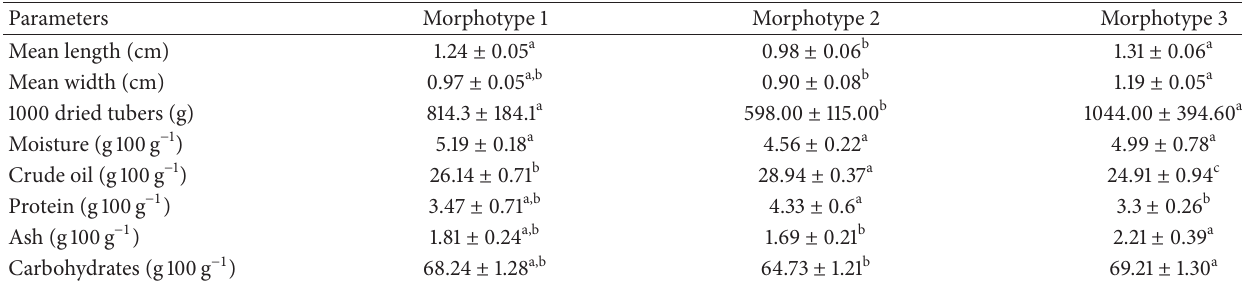
Values are means ± standard deviation for 𝑛 = 3 . Data in the same row followed by different letters are significantly different ( p < 0.05).